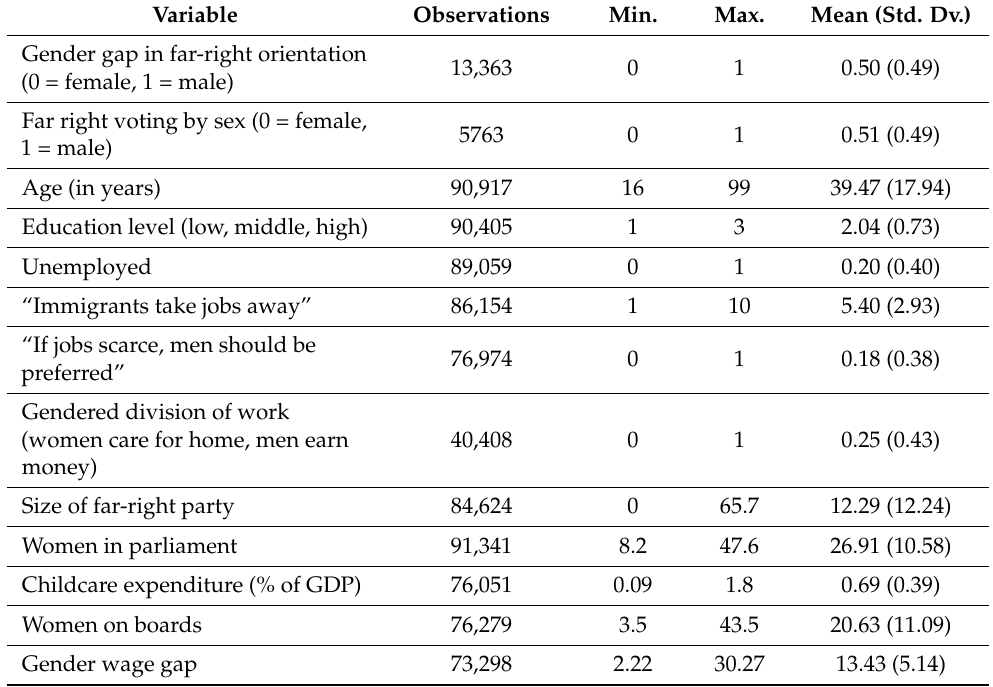
Table A3. Descriptive Statistics.